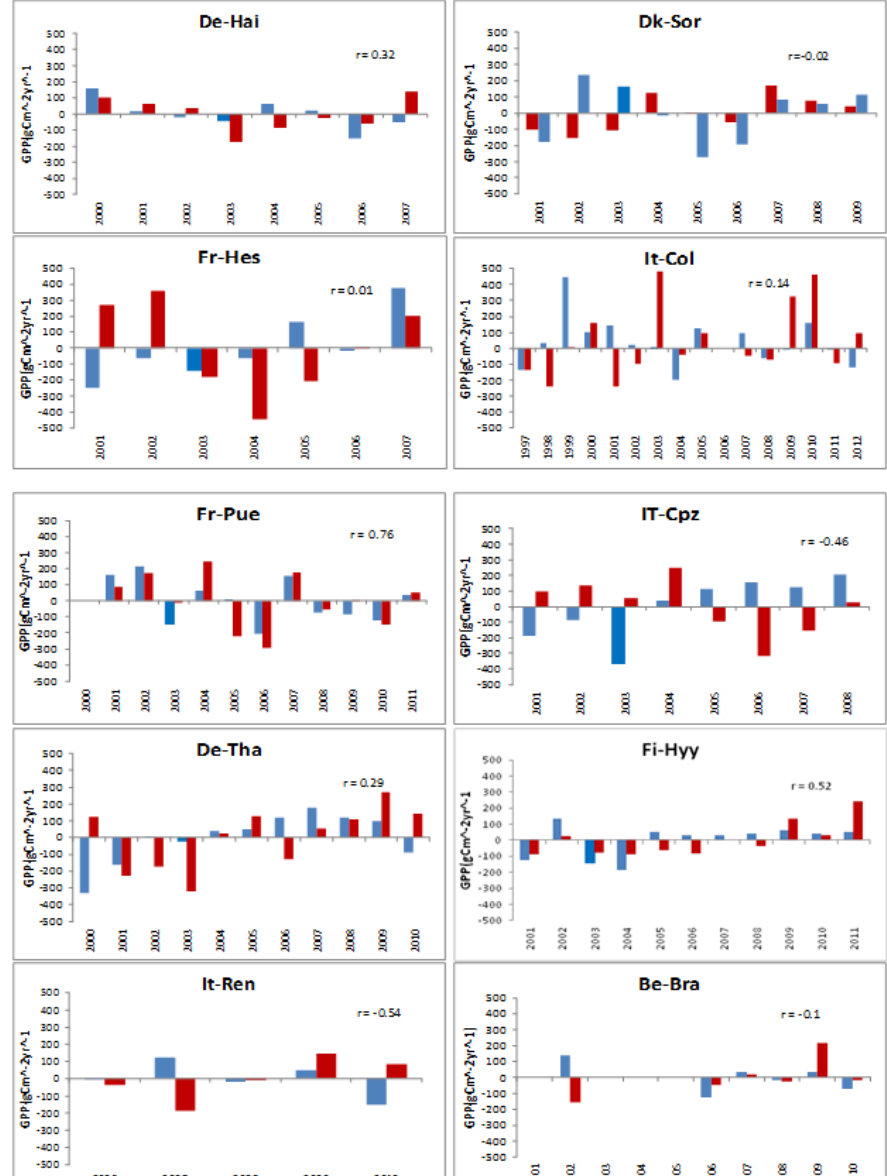
Figure 9. Inter-Annual Variability (IAV) based on Keenan et al. (2012). Red and blue bars indicate the observed and modelled IAV values, respectively; r values refer to correlation between observed and modelled variations. DE-Tha refers to the 1S simulation, IT-Ren to the 2L_2C simulation, BE-Bra to the P_Q-3L simulation (see